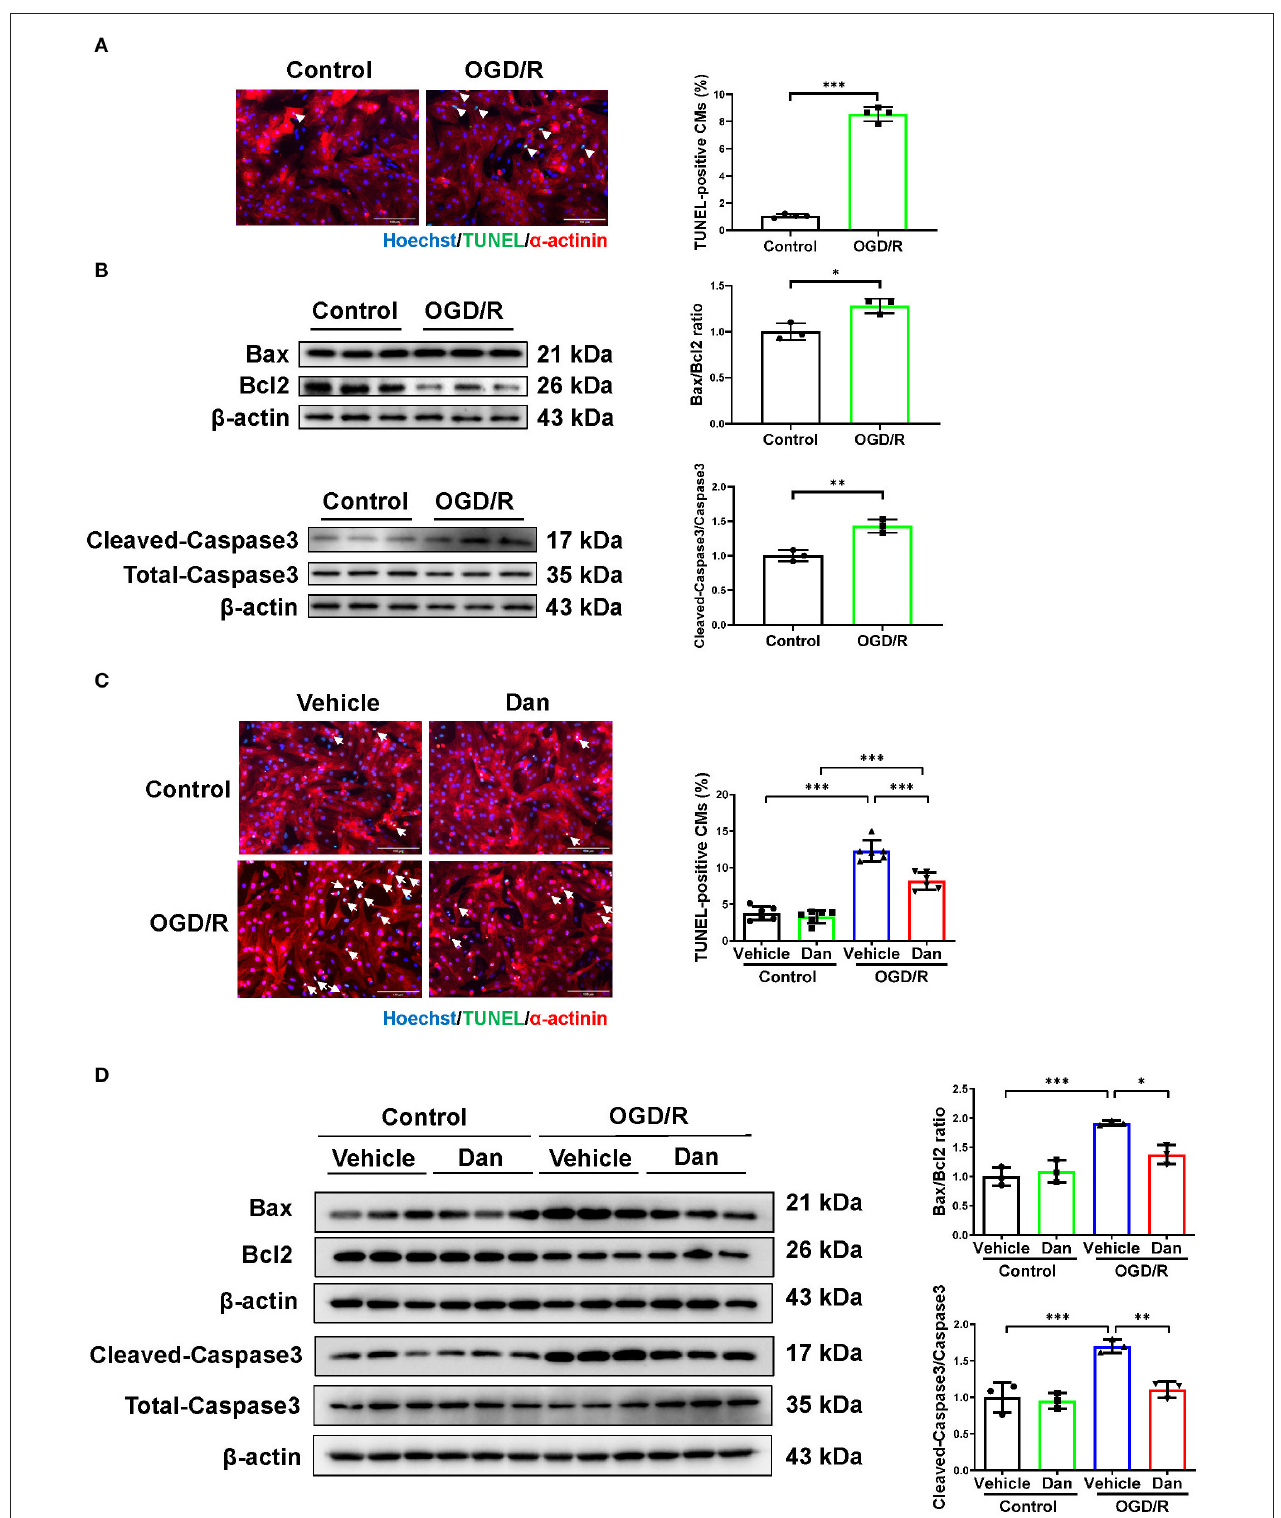
FIGURE 2 | Dan attenuates oxygen-glucose deprivation–reperfusion-induced CM apoptosis in vitro . (A) Primary NRCMs were submitted to oxygen-glucose deprivation–reperfusion (OGD/R) modeling to induce apoptosis. TUNEL/ α -actinin staining was performed to assess CM apoptosis ( n = 4). Scale bar = 100 µ m. (B) Western blot analysis for apoptotic-associated proteins in OGD/R-induced apoptosis of NRCMs ( n = 3). (C) TUNEL/ α -actinin staining for OGD/R-induced apoptosis of NRCMs in the presence or absence of Dan treatment ( n = 6). Scale bar = 100 µ m. (D) Western blot analysis for apoptotic-associated proteins in OGD/R-induced apoptosis of NRCMs in the presence or absence of Dan treatment ( n = 3). * p < 0.05; ** p < 0.01; *** p < 0.001.